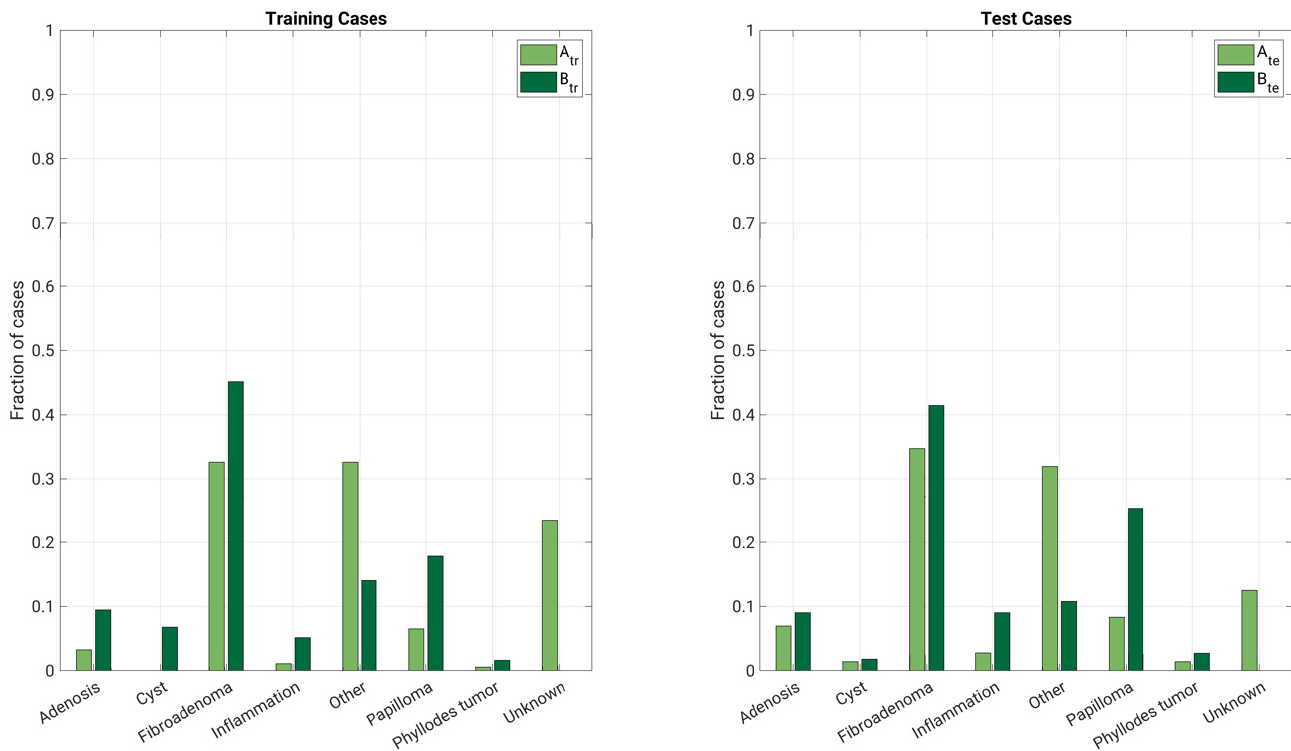
Figure 2. Description of the dataset: fraction of types of benign lesions (one lesion per case) by database (A: Database A; B: Database B; tr: training; te: test).